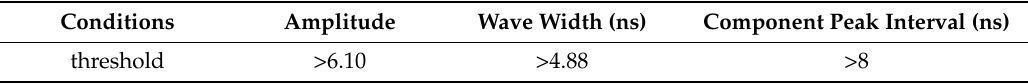
Table 4. Limiting conditions for screening the reflected components.